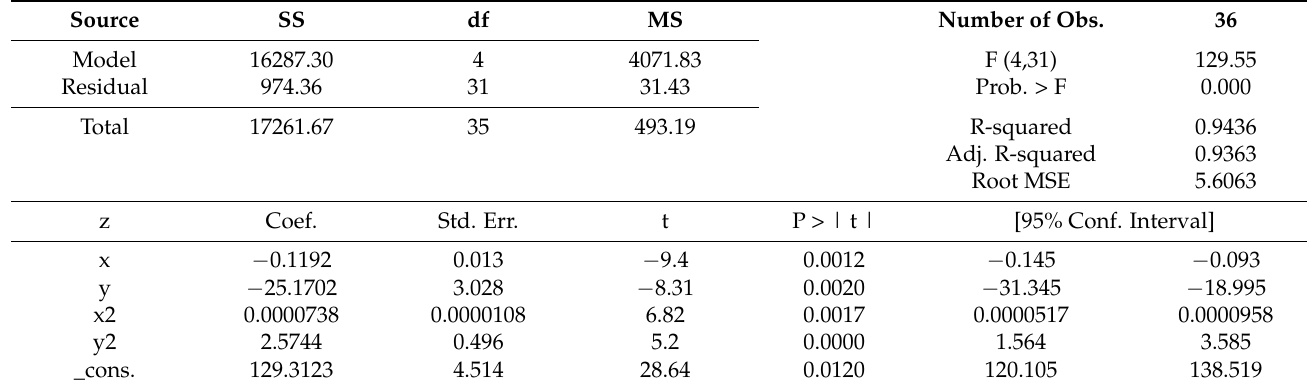
Table 12. Regression analysis with all items but the